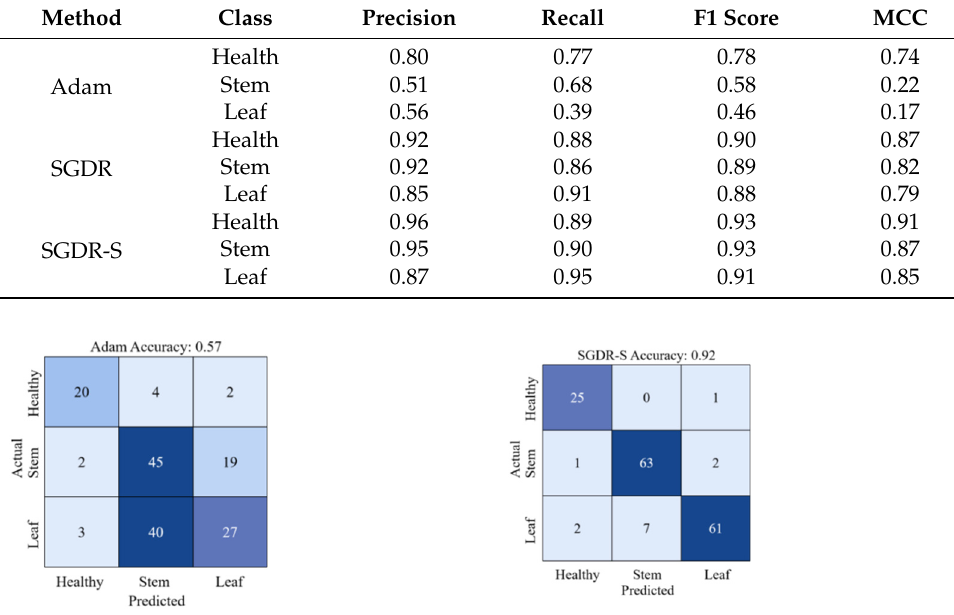
Figure 6. Classification accuracy and confusion matrix for both Adam and SGDR-S algorithms.